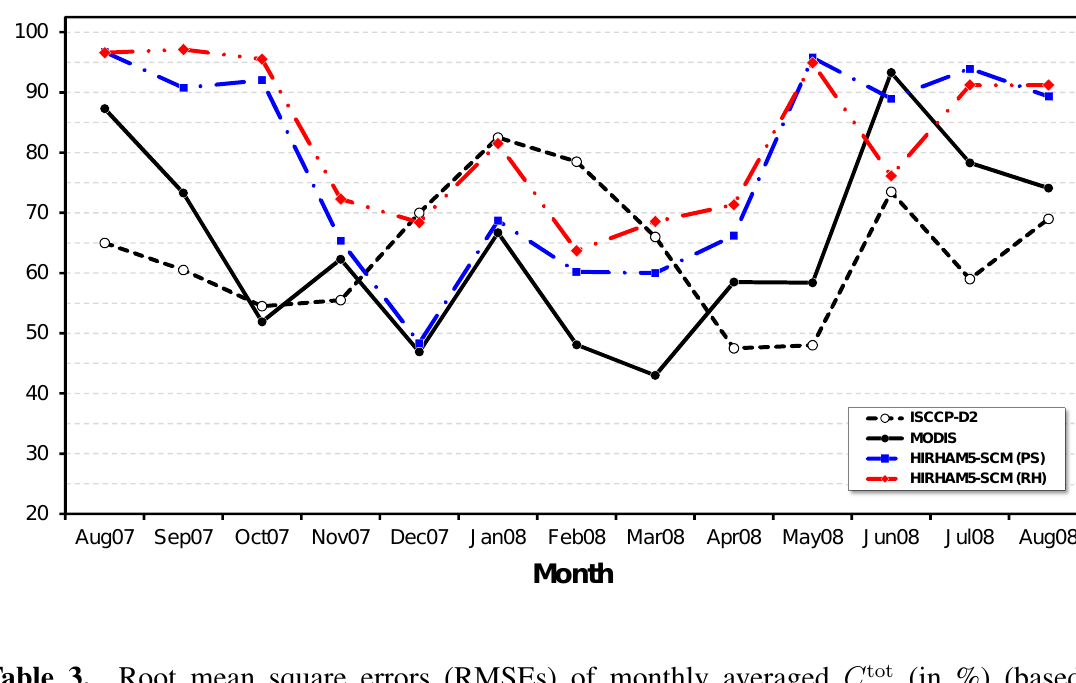
Figure 4. Monthly means of total cloud cover C tot (in %) from August 2007 to August 2008 referring to the NP-35 start position. The results originate from both ISCCP-D2 ( short dashed black line ) and MODIS ( solid black line ) satellite observations, and HIRHAM5-SCM simulations using either the PS-Scheme ( blue line ) or the RH-Scheme ( red line ).